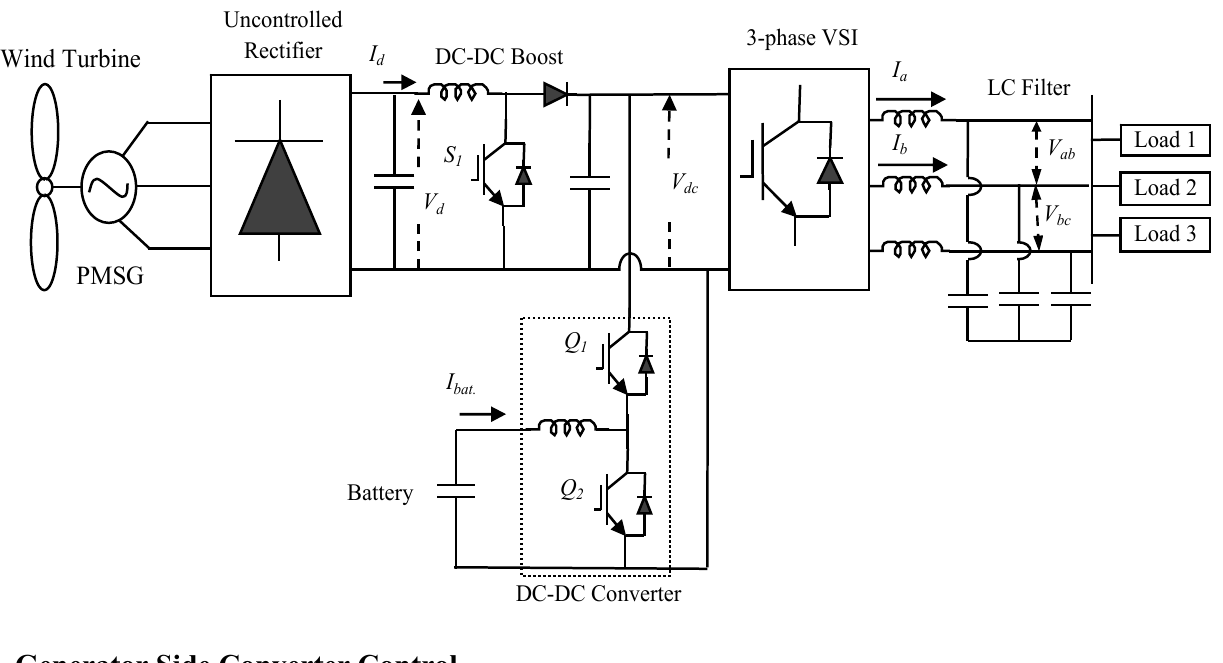
Figure 1. Power circuit topology of a variable speed stand-alone wind energy supply